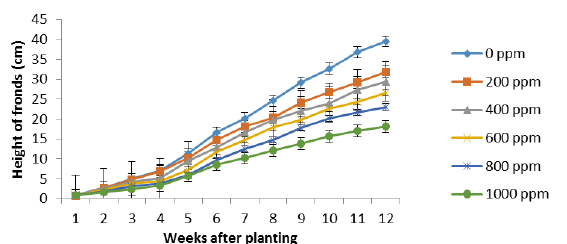
Fig. 3. E ffect of different treatments of lead on the leaflet area of Pteris vittata